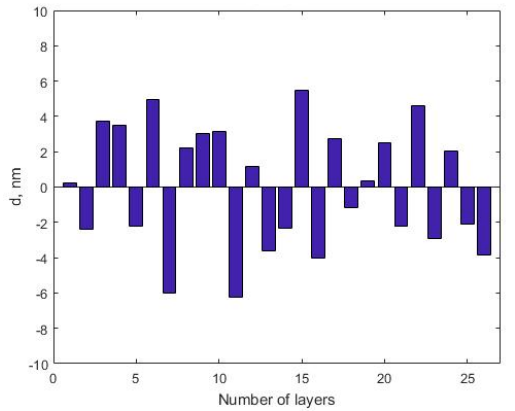
Figure 1. Deviations of actual layer thickness from the theoretically planned layer thickness in one of the simulated deposition processes.